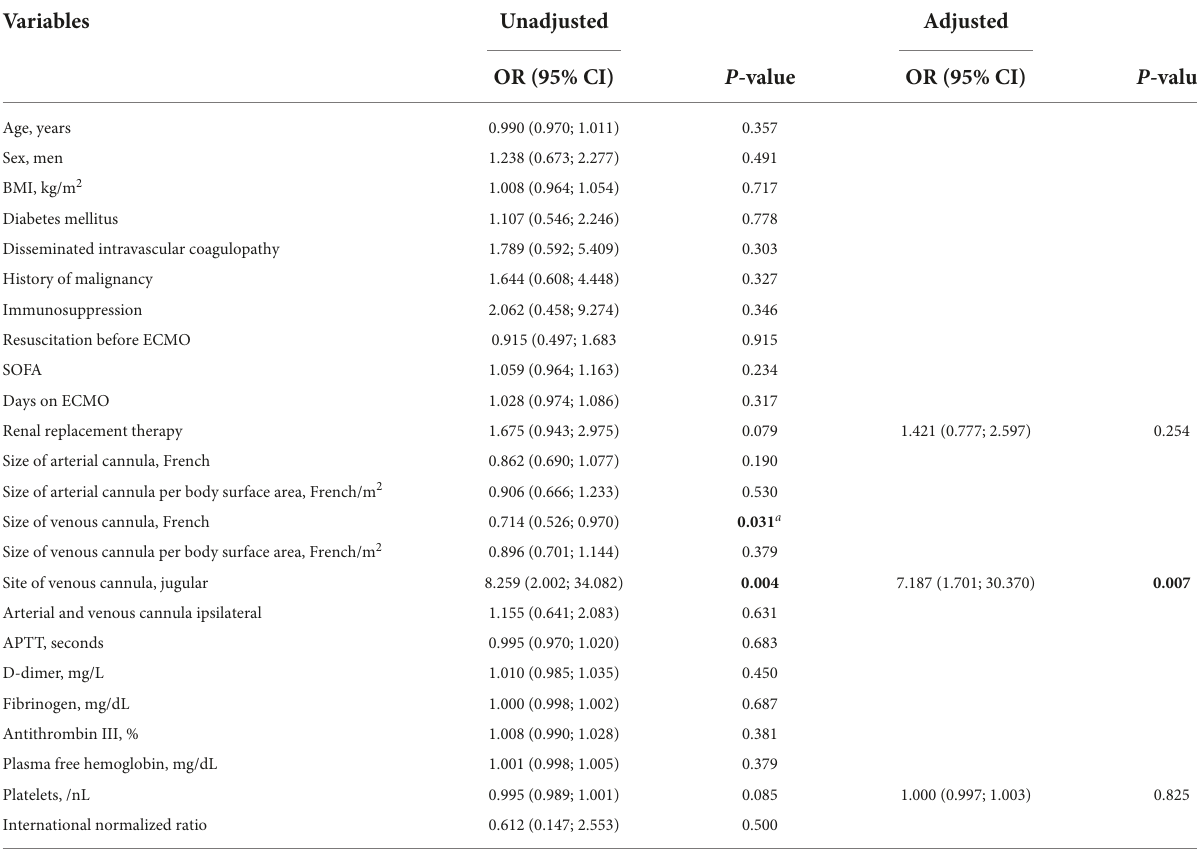
TABLE 2 Univariate and multivariate binary logistic regression models for venous thrombosis in survivors of venoarterial extracorporeal membrane oxygenation.